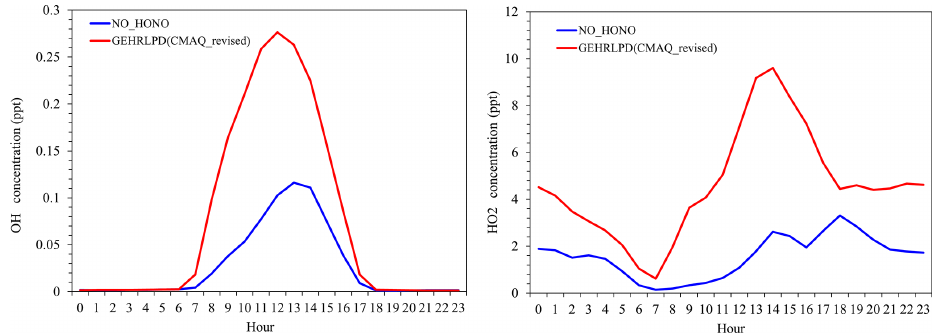
Figure 4. Average diurnal variations of OH and HO 2 mixing ratios simulated in the NO_HONO and GEHRLPD cases at the Heshan site during 4–8 January 2017.